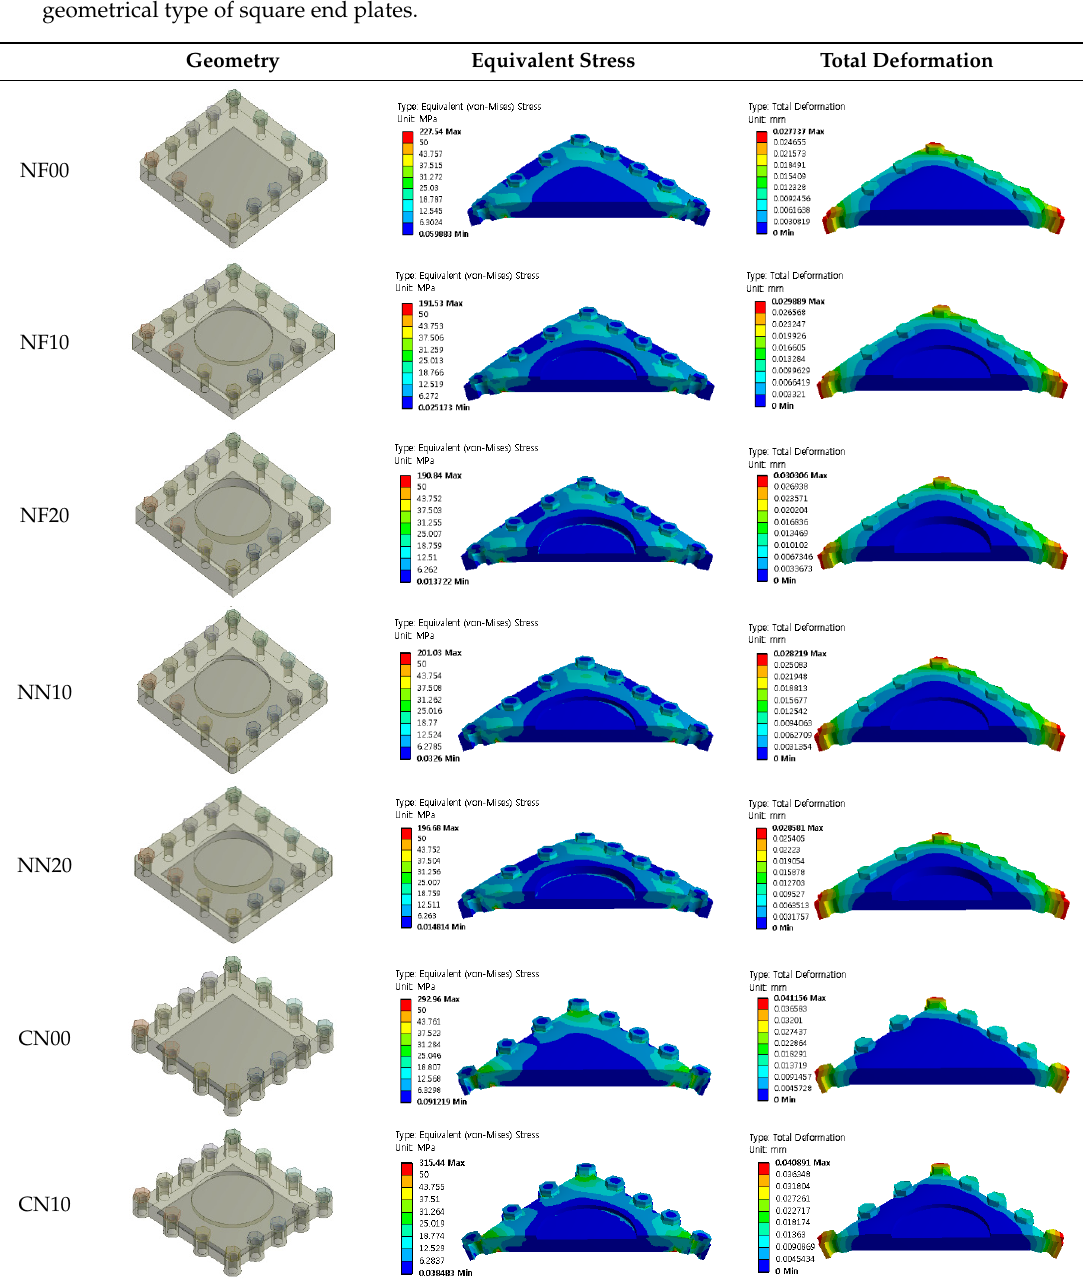
Table 4. Equivalent stress distribution and total deformation simulation results of the various geometrical type of square end plates.